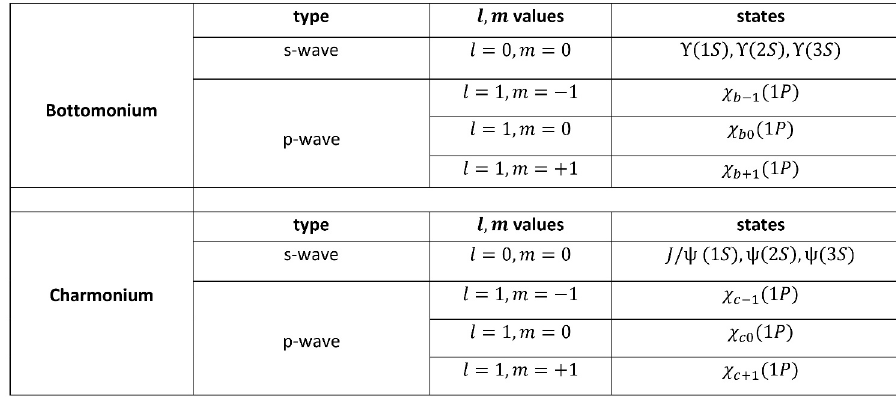
Table 1. l and m values of various quarkonium states.